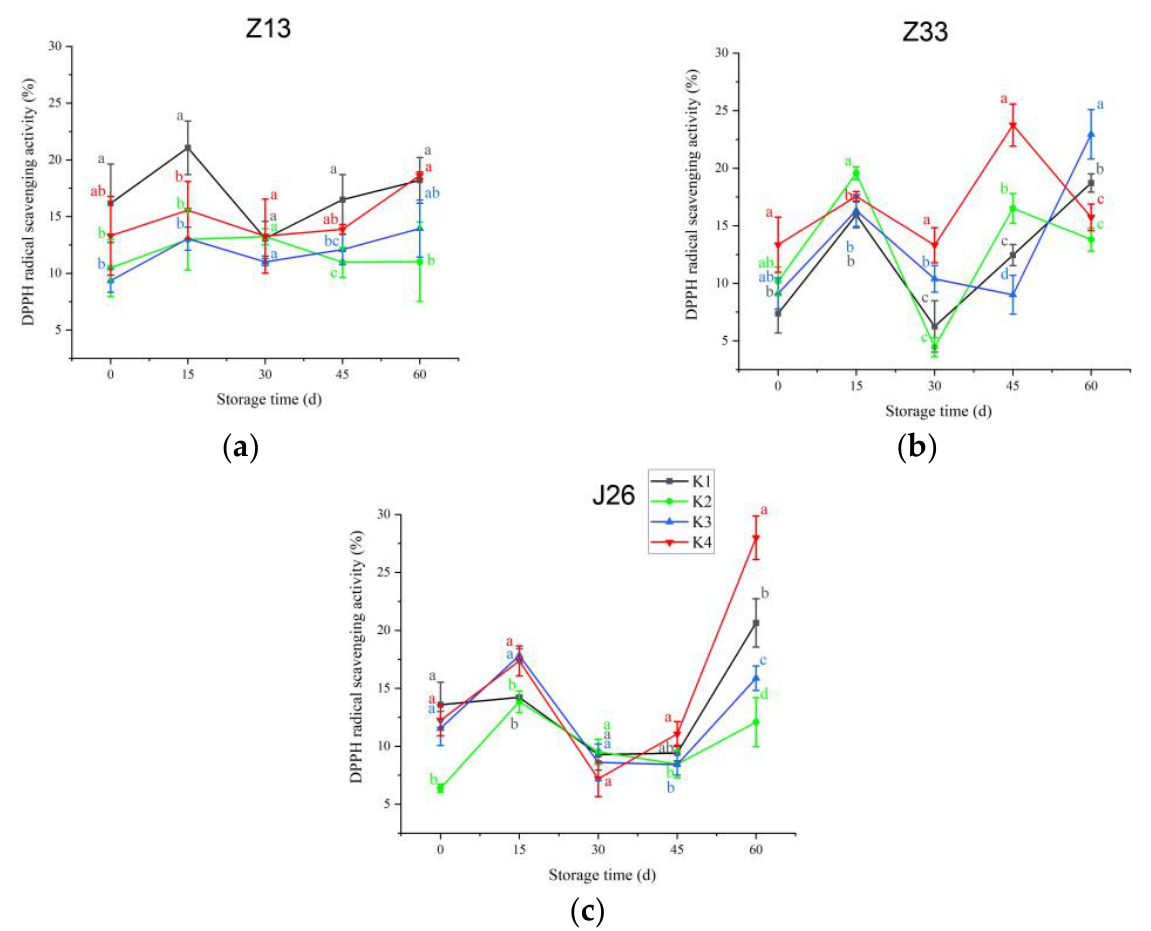
Figure 9. DPPH radical-scavenging activity of the tuberous root of different UCZ treatments during storage. ( a ) Z13; ( b ) Z33; ( c ) J26. Values within the same storage day followed by the same letter are not significantly different at the 5% level according to ANOVA-Duncan’s multiple range test. K1: Normal basal fertilizing without UCZ; K2: Normal basal fertilizing with UCZ; K3: Rich basal fertilizing without UCZ; K4: Rich basal fertilizing with UCZ.